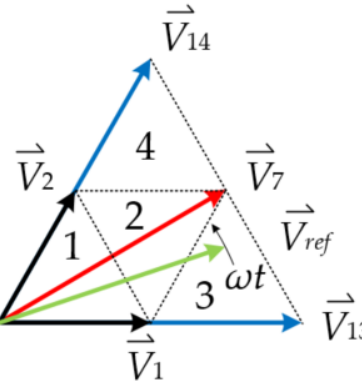
Figure 3. First sector divided into regions.